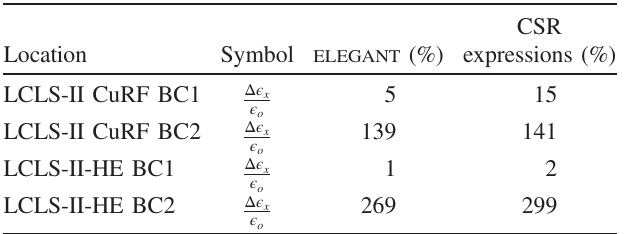
TABLE III. The LCLS-II CuRF and LCLS-II-HE BC1 and BC2 emittance calculation comparison between ELEGANT and our analytical